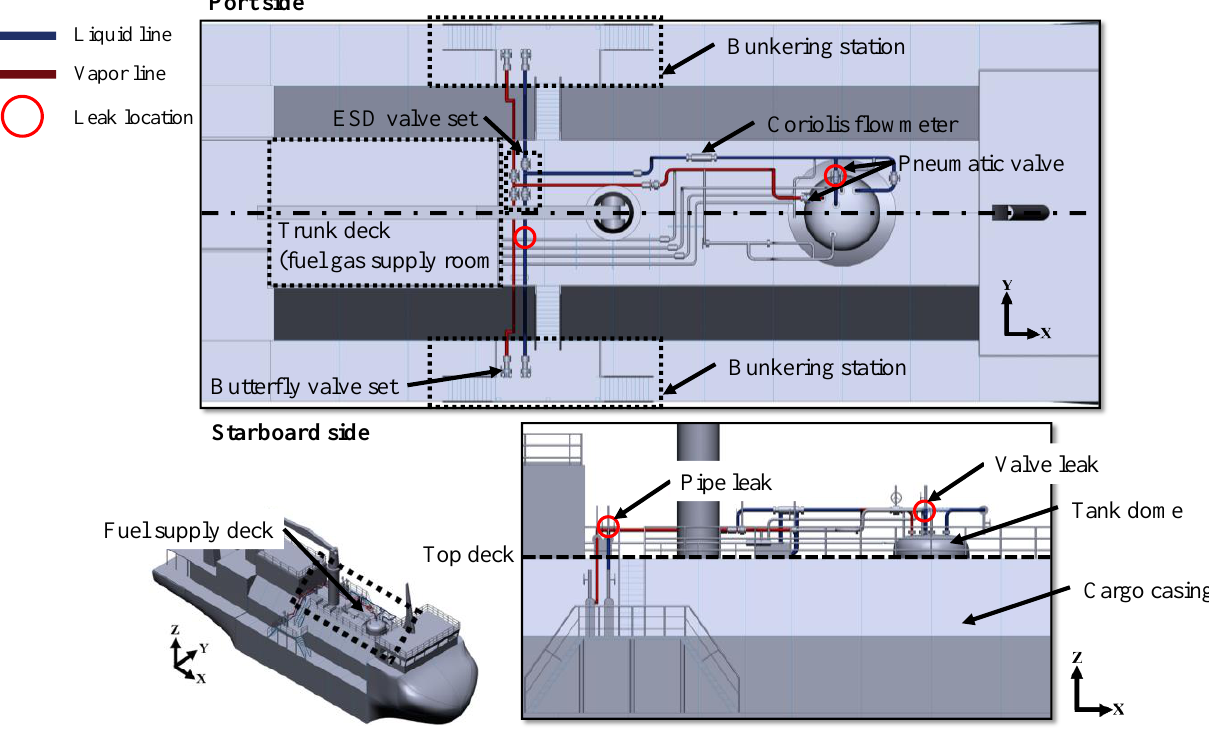
Figure 4. Two leak positions in the fuel supply deck of the LNG bunkering